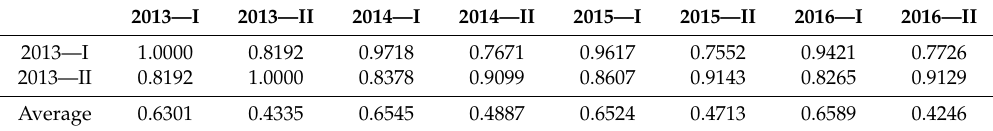
Table 5. Correlation test of e ffi ciency value in two stages from 2013 to